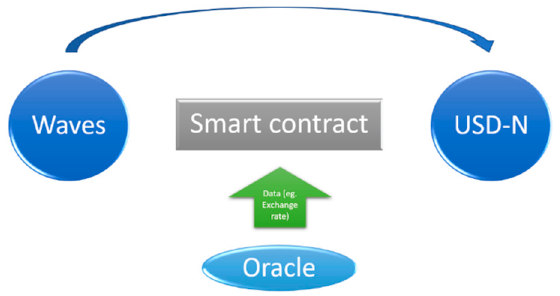
Figure 2. Crypto swap including an oracle.